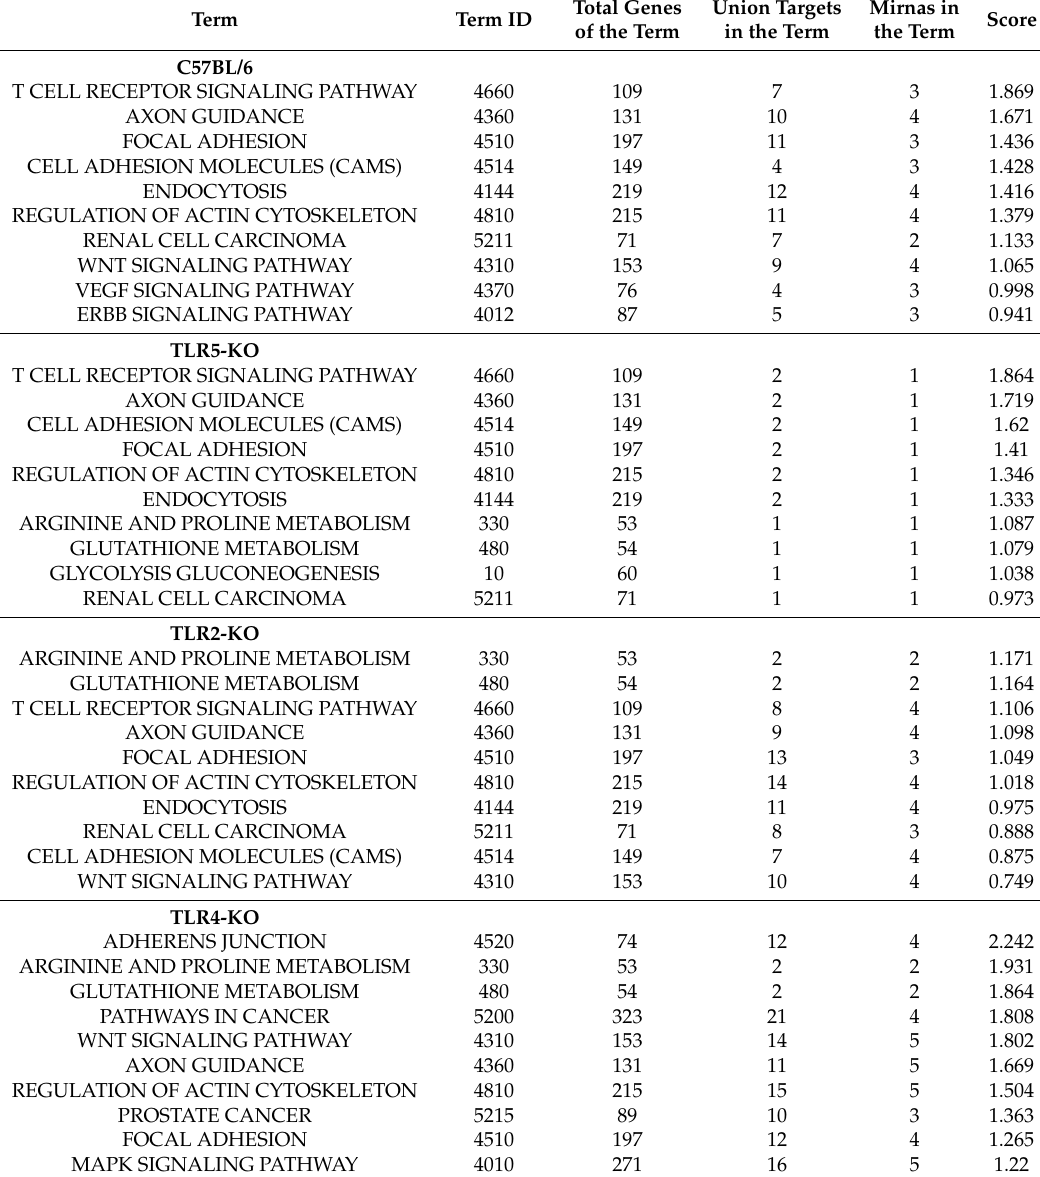
Table 1. The top 10 Kyoto Encyclopedia of Genes and Genomes (KEGG) pathways involved in weight reduction in C57BL/6, Tlr5, Tlr2, Tlr4